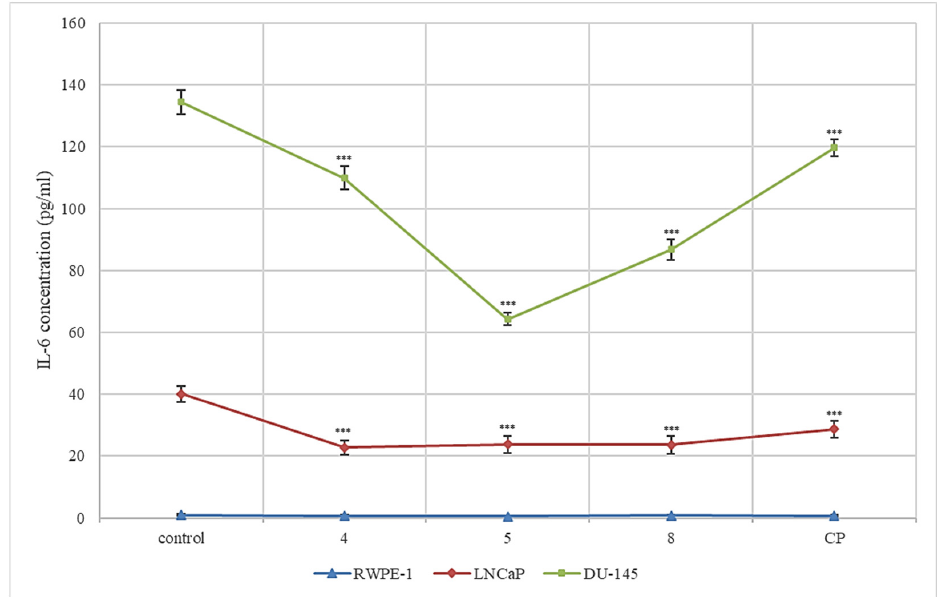
Figure 5. IL-6 concentration determined by ELISA method in the tested cell lines LNCaP, DU145 and RWPE-1 treated with new ciprofloxacin derivatives 4 , 5 and 8 and free ciprofloxacin (CP). Significance levels explanation *** p < 0.001 as compared to the controls.